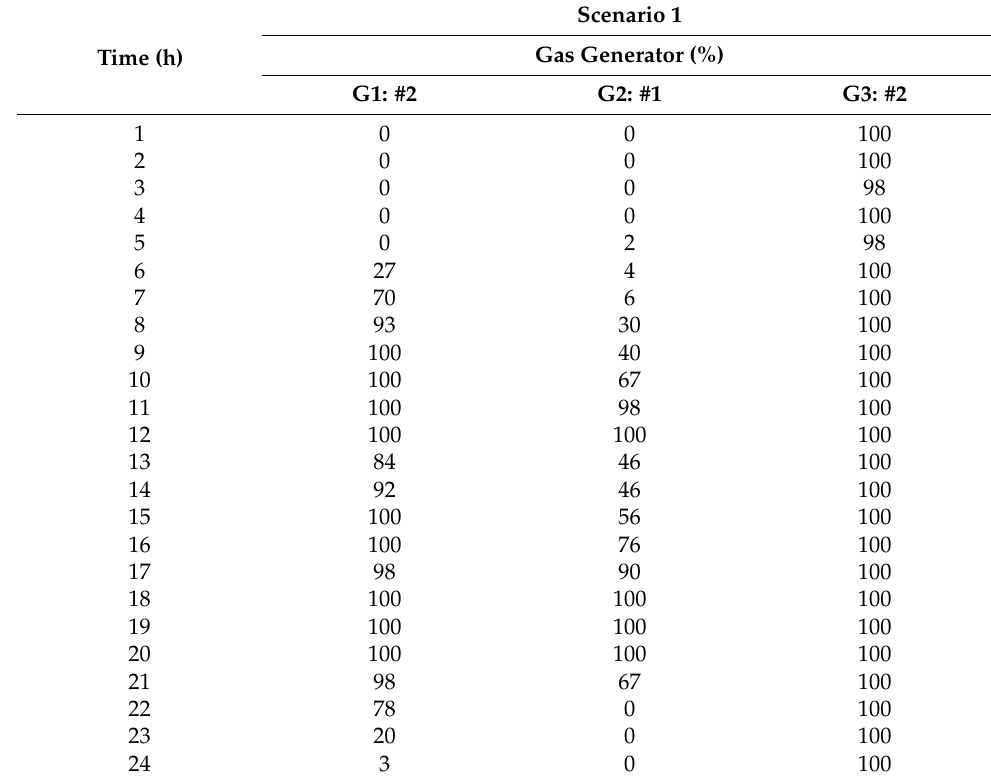
Table A7. Hourly output of gas-fired generators in Scenario 1.